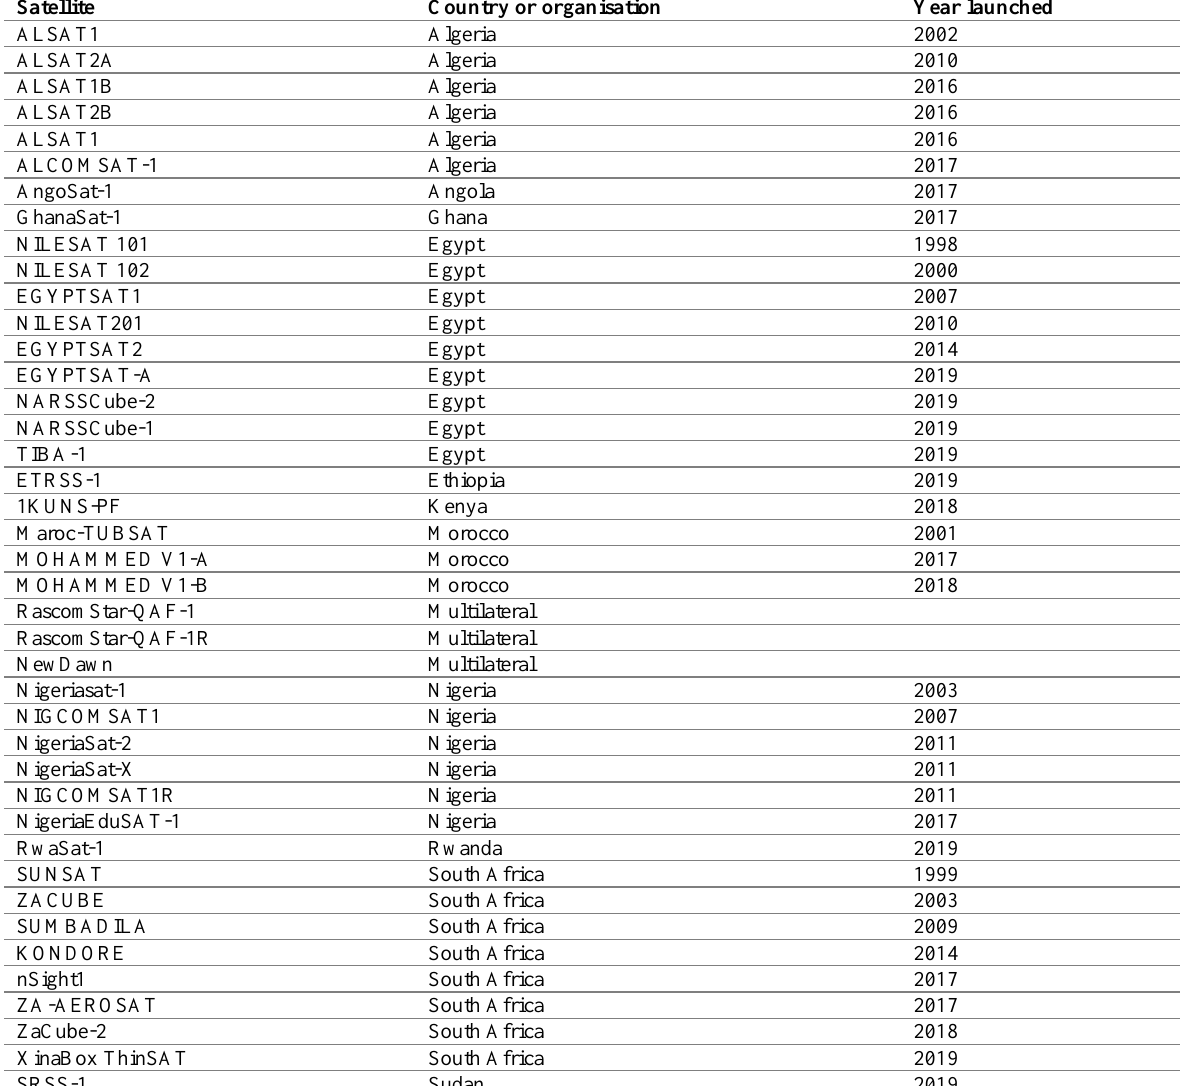
Table 2: African countries’ satellites constructed, purchased, or